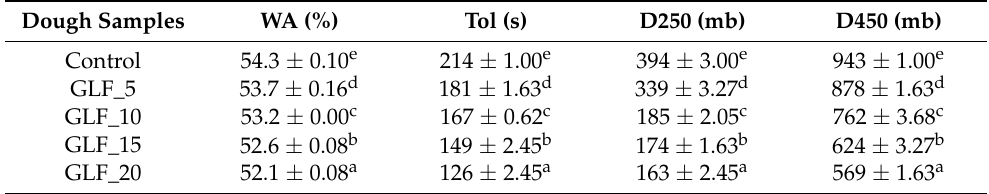
Table 1. Consistograph parameters of the dough samples with different levels of GLF additions.